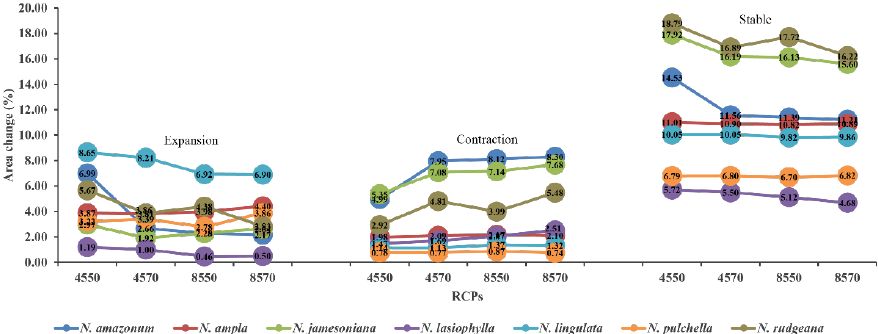
Figure 3. Future distribution changes in expansion (habitat gain), contraction (habitat loss), and stable environment among the seven Nymphaea